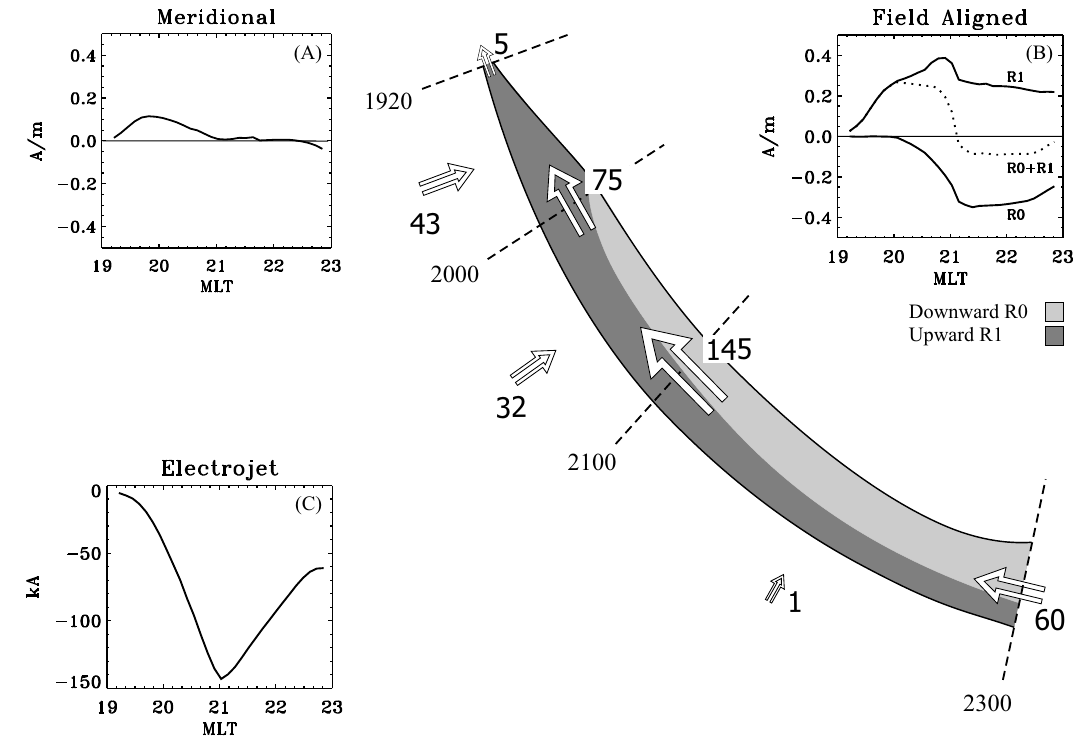
Fig. 7. An illustration of the ionospheric part of the substorm current wedge from Gjerloev and Hoffman (2002). Numbers are in kA and arrows indicate direction of horizontal current direction. Although the arrow size implies strength of current they are not to be scaled. The arrows outside the wedge itself indicate the meridional current contribution to the wedge system. The two top panels show the meridional current intensity along the low-latitude boundary of the wedge and the field-aligned current intensity within the wedge. Finally, the bottom left panel shows the total wedge electrojet strength as a function of